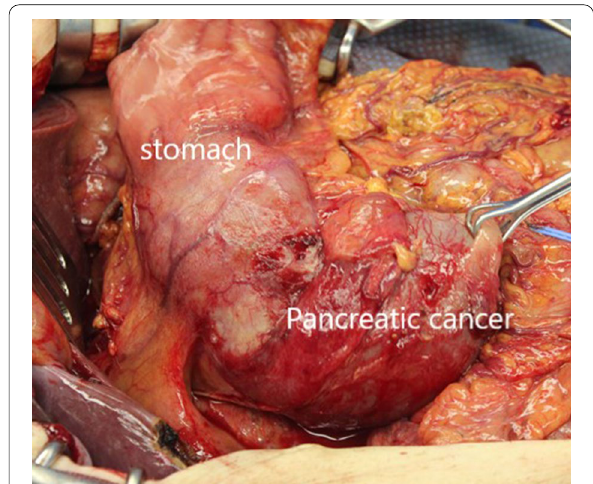
Fig. 5 Operation findings. 1. A huge tumor was found in the pancreatic head